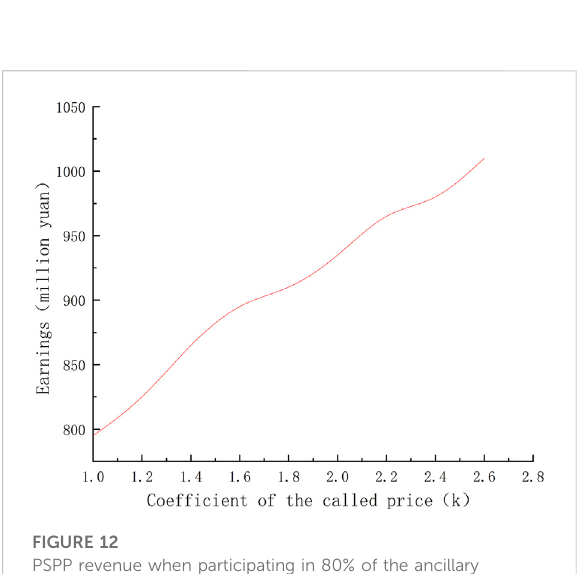
FIGURE 12 PSPP revenue when participating in 80% of the ancillary services market.